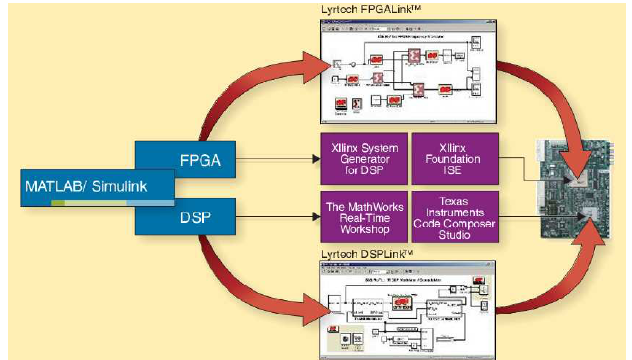
Figure 20. Using SFF SDR platform in module-based design